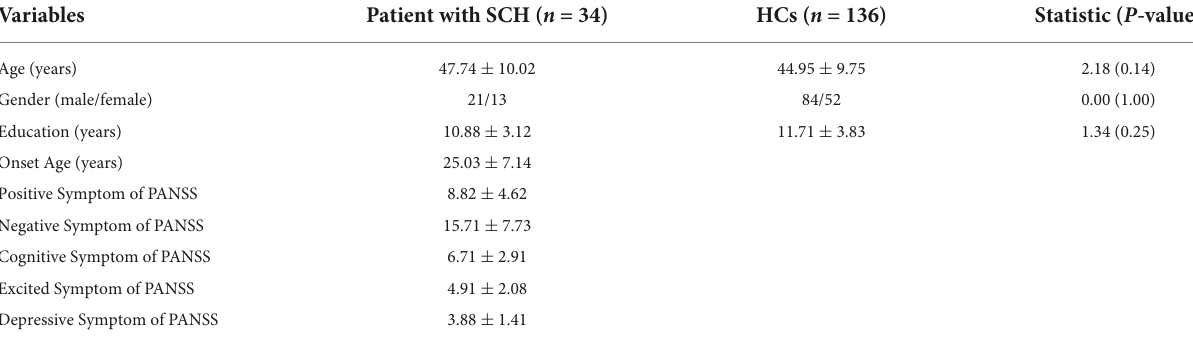
TABLE 1 Demographic and clinical variables in patients with schizophrenia (SCH) and healthy controls (HCs).